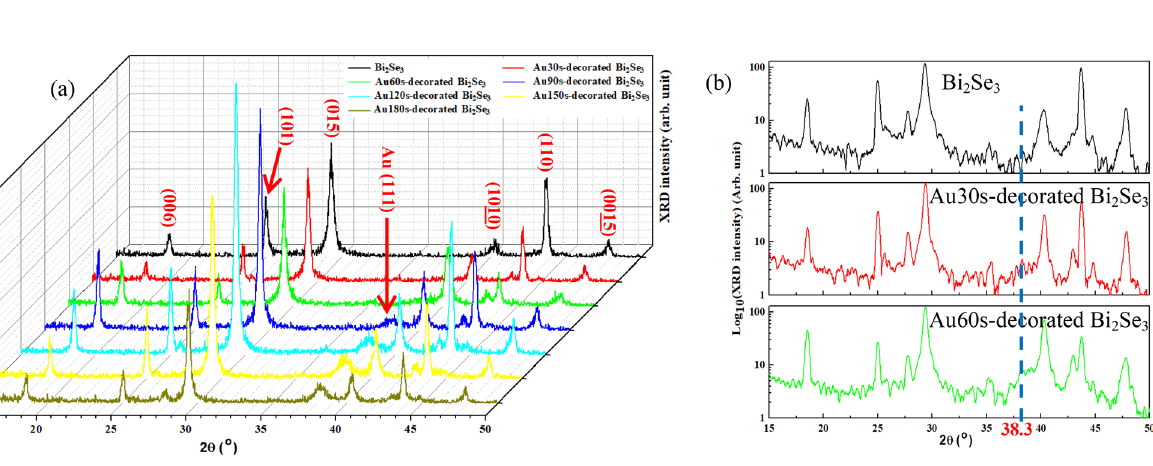
Table 1. Thicknesses and diameters of the Au-decorated Bi 2 Se 3 NPs with various Au deposition time.